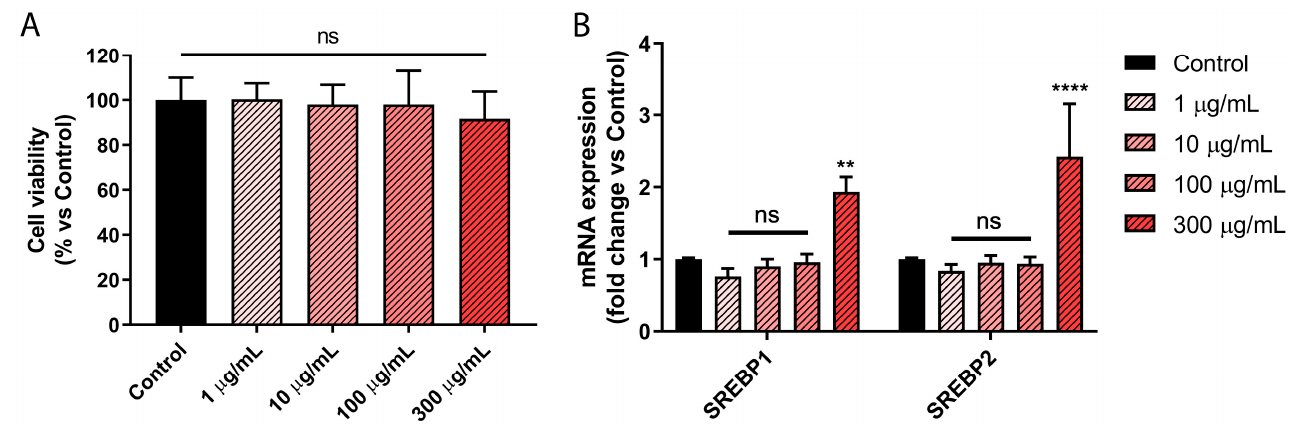
Figure 3. Effects of picrocrocin in HepG2 cells. ( A ) Cell viability assessment of HepG2 cells after treatment for 72 h, with increasing concentrations (1 to 300 µg/mL) of PEF from saffron extract. ( B ) qPCR analysis of SREBP1 and SREBP2 transcription levels after treatment for 24 h. The relative expression of human SREBP1 and SREBP2 were determined by Sybr green qPCR. The ∆ Ct of human PPIA was used as an internal calibrator. These results highlight PEF’s ability to increase mRNA levels of SREBP1 and SREBP2 in HepG2 cells without affecting cell viability. Values represent mean ± SD of three independent experiments. ** p value < 0.01; **** p value < 0.0001; ns: non-significant.